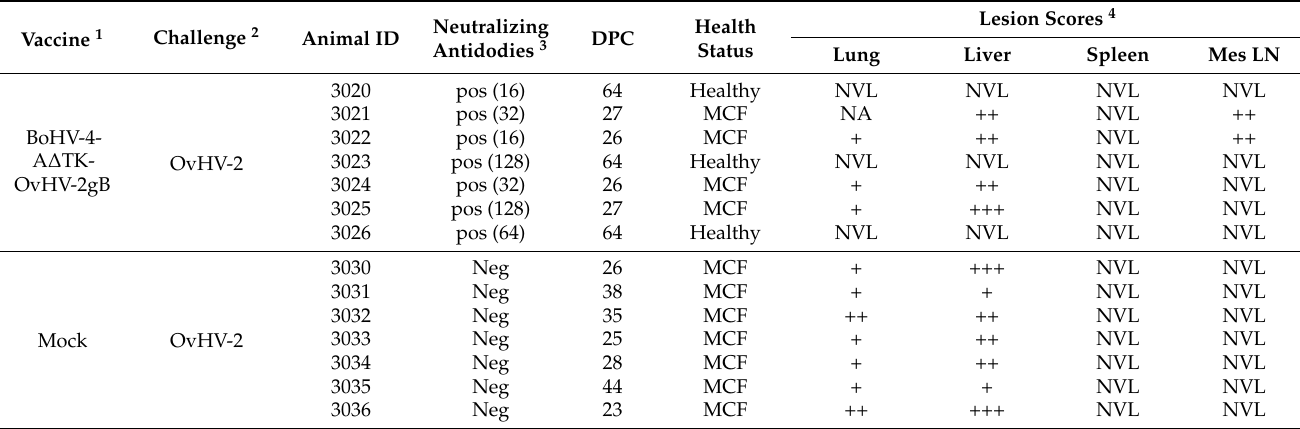
Table 2. Health status, neutralizing antibody response, and lesion scores in an SA-MCF vaccine-challenge trial using a recombinant BoHV-4 delivering OvHV-2 gB in a rabbit model. Vaccine